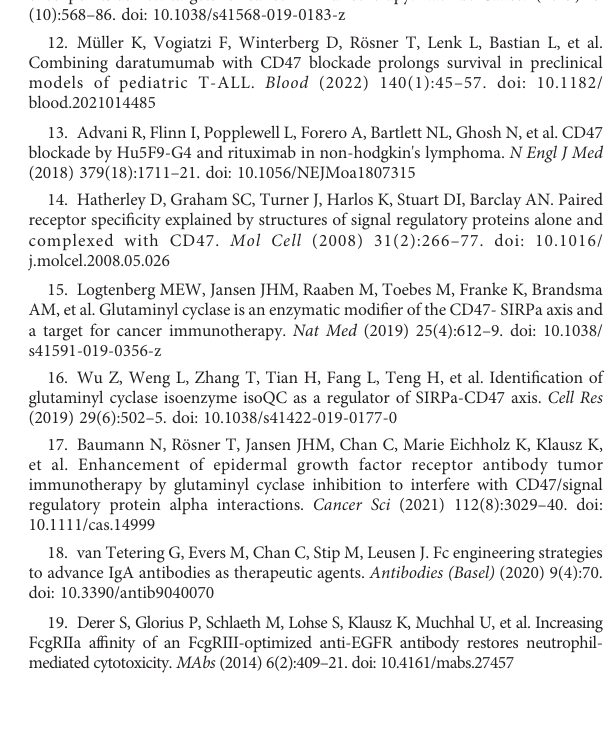
SUPPLEMENTARY FIGURE S1 Biochemical characterization of an IgA2 version of daratumumab (DARA- IgA2). (A) HP-SEC pro fi leof the IgA2 variant of DARAshowing thepurity of the IgA2 antibody preparation after production in CHO-S cells and puri fi cation via af fi nity chromatography. (B) DARA-IgA2 antibody preparations were separated by SDS-PAGE and gels were stained with Coomassie blue. One speci fi c band at approx. 150 kDa was detected under non-reducing conditions (left panel) representing the complete IgA2 antibody.Underreducing conditions(right panel),twospeci fi cbands representing the heavy chain (HC) at 50 kDa and the light chain (LC) at 25 kDa. (C) Binding of saturating concentrations (10 µg/ml) of IgG1 and IgA2 variants of DARA to human CD38 transfected CHO-K1 cells was detected by fl ow cytometry using FITC-labelled anti-human IgG or IgA heavy chain-speci fi c secondary antibodies. The MFI values ± SEM of three experiments are shown. (D) Dose-dependent binding to CD38 transfected CHO-K1 cells of DARA-IgG1 and DARA-IgA2 variants at increasing concentrations was analyzed by indirect immuno fl uorescence using an anti-human kappa light chain-directed FITC-labelled secondary antibody. Results are presented as MFI ± SEM from 3independent experiments. MFI, mean fl uorescence intensity; mAU, milli absorbance units; ctrl., control; mAb, monoclonal antibody. SUPPLEMENTARY FIGURE S2 M0 donor dependency on ADCP of primary T-ALL cells. ADCP of primary T- ALL cells was performed in the absence or presence of the CD47 blocking antibody 5F9-IgG2 s (20 µg/ml). Patients were illustrated by different colors. DARA-IgA2 and isotype control were used at 10 µg/ml. An E:T cell ratio of 1:1 was applied. Shown are the red object counts per image (ROI) at maximal phagocytosis. * indicates signi fi cant differences between DARA-IgA2 and isotype control, # depicts signi fi cant differences between with and without CD47 blockade (p < 0.05 by two-way ANOVA). n.s., not signi fi